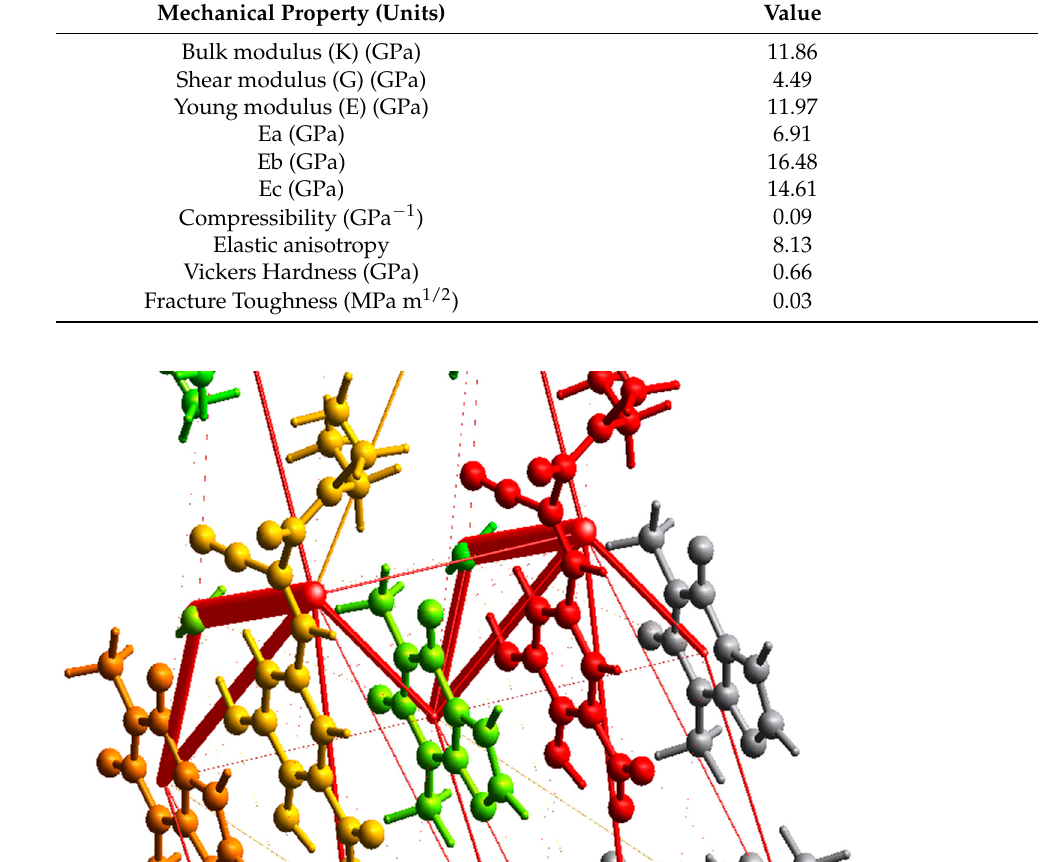
Table 4. Calculated mechanical properties of ENT-THP-water cocrystal.